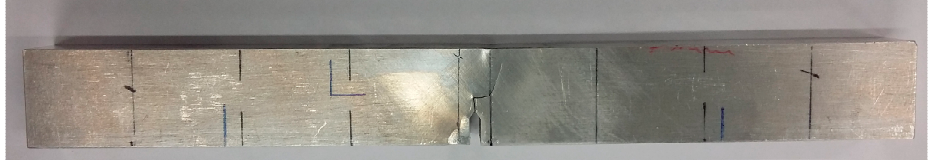
Figure 5. 4-pont bend test, showing machined V notch, subsequent mode I precrack, and FCG path starting at the precrack; details in [5].